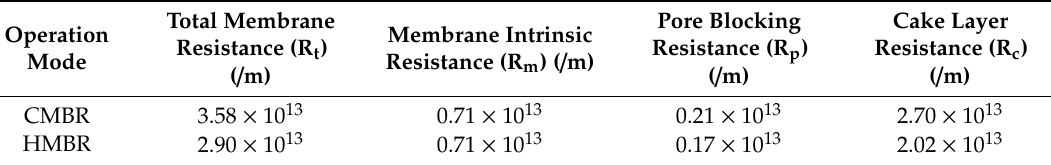
Table 3. Comparison of membrane resistance for conventional membrane bioreactor (CMBR) and hybrid membrane bioreactor (HMBR).